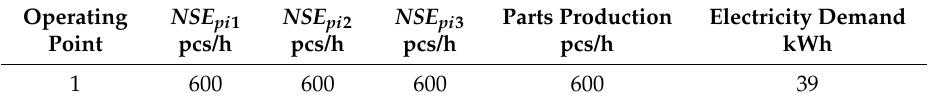
Table 2. Operating points of parts production system (PPS)#1 and 2 during each time interval, i = 1, 2.